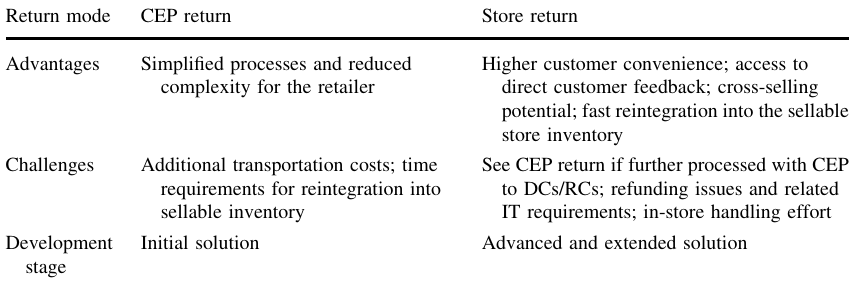
Table 5 Summary of omni-channel return modes Return mode